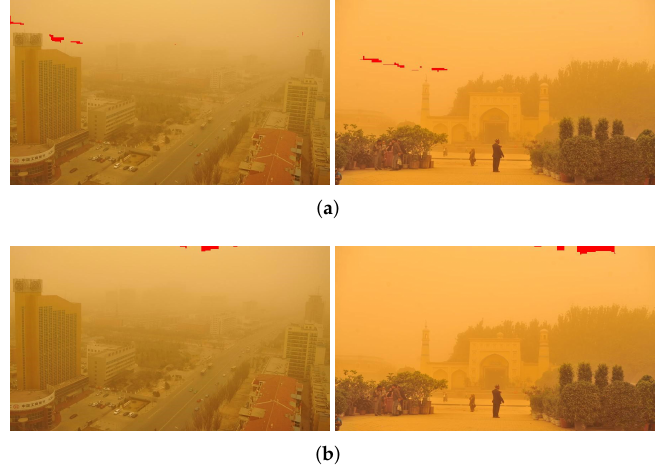
Figure 5. Atmospheric light position selected by two algorithms: ( a ) Proposed algorithm; ( b ) Dark channel prior